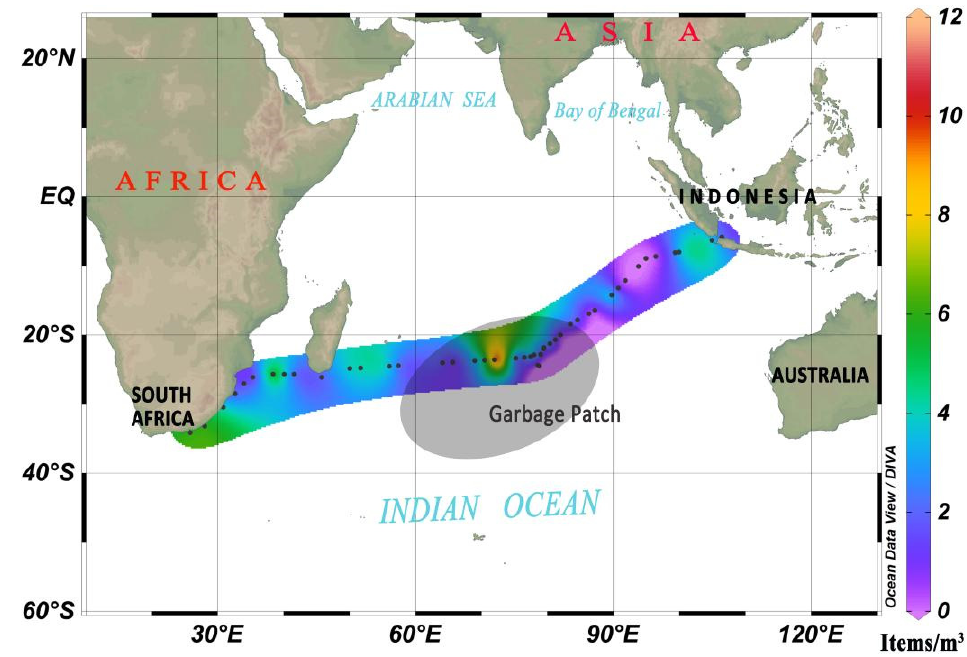
Figure 2. Sampling sites and abundance distribution of microplastics (“ · ” sampling stations).